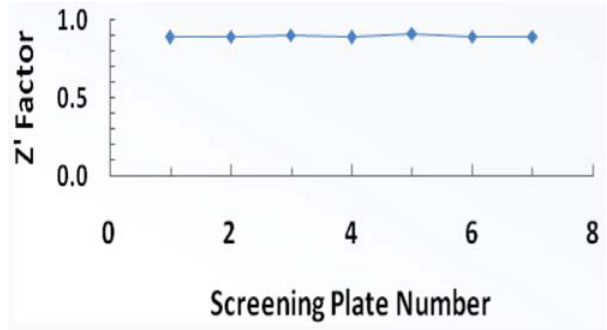
Figure 3. Robustness of screening assay: Z’ factor during the experiment averaged 0.89.